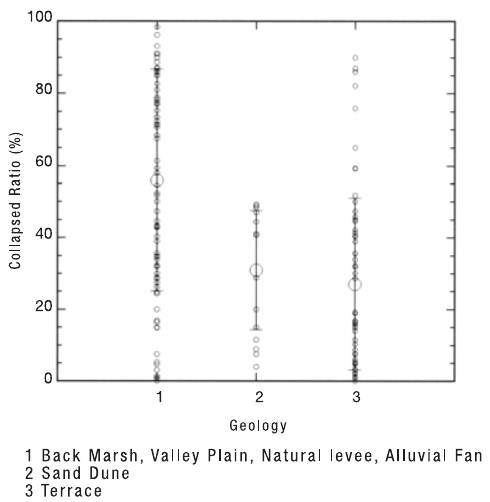
Fig. 9. Collapsed ratios at different geomorphological